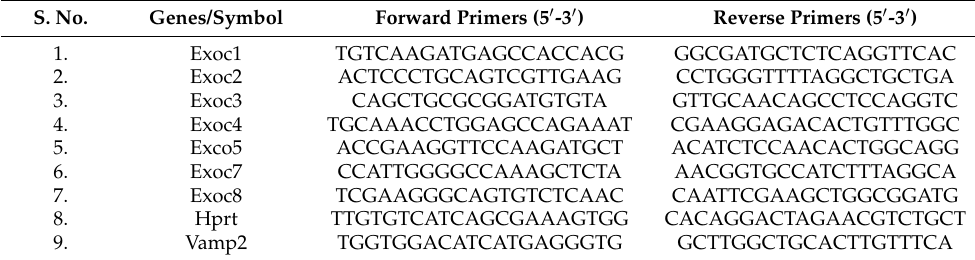
Table 1. SYBR green primers